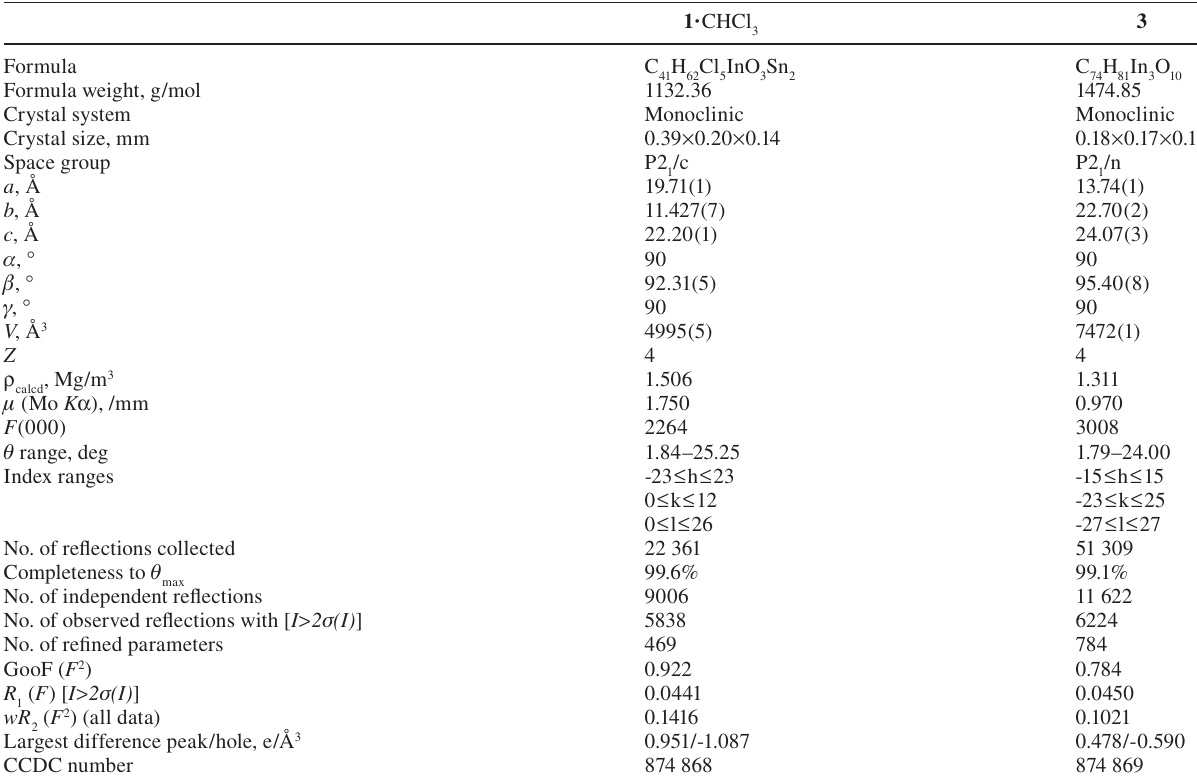
Table 1 Crystal data and structure refi nement of 1 and 3 .